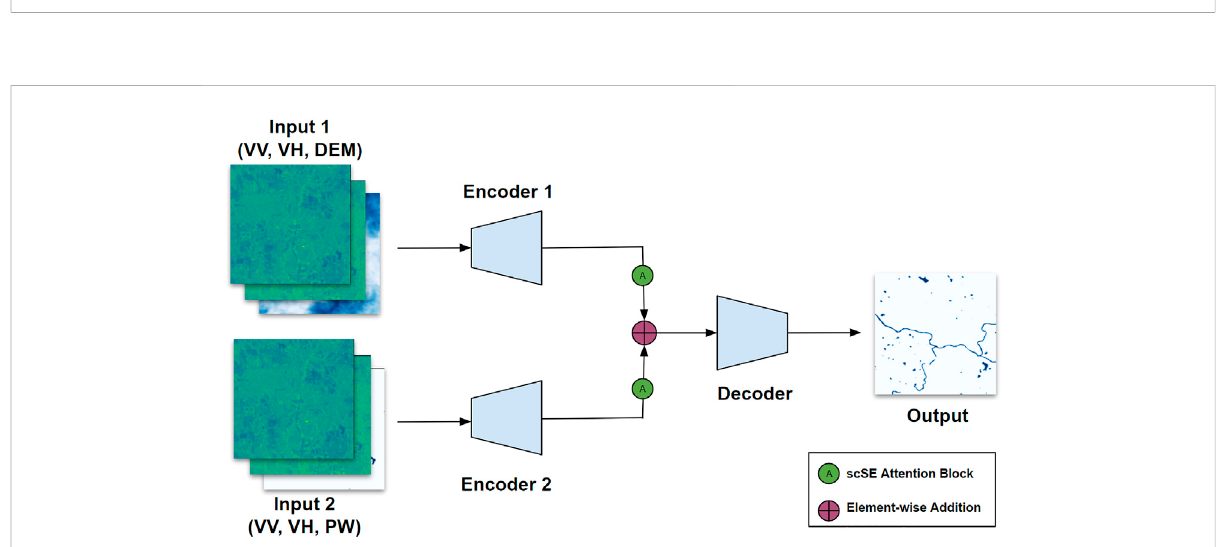
FIGURE 4 Fusion Network. Input1 is a 3-channel input with VV, VH, and DEM bands, Input2 is also a 3-channel input with VV, VH, and PW bands. The two encodersanddecoderfollowasimilararchitectureasthatof ‘ AttentiveU-net ’ .Theattentiveoutputofthetwoencodersisfusedusingelement-wise addition operations, and the output of the network is a binary segmentation map.